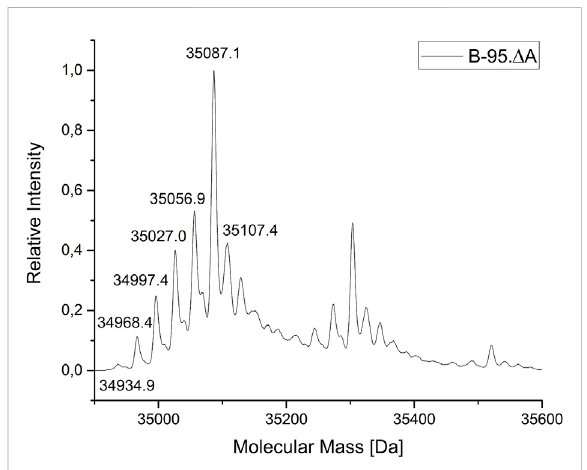
FIGURE 5 Mass pro fi le (ESI-MS) of ELP(5x m - o NB-Dopa)-sfGFP produced in E. coli B-95. Δ A. The peak pattern shows a characteristic mass shift in line with nitro group reductions (with massdifferences fi ttingtotheoreticalvaluesforthereduction of the ncAA nitro group). Deconvoluted intact protein mass values and shifts are given in Table 1. The main peak (35087.1 Da) indicates the target species with fi ve ncAAs and devoid of nitro group reduction. The corresponding chemistry is explained in the main